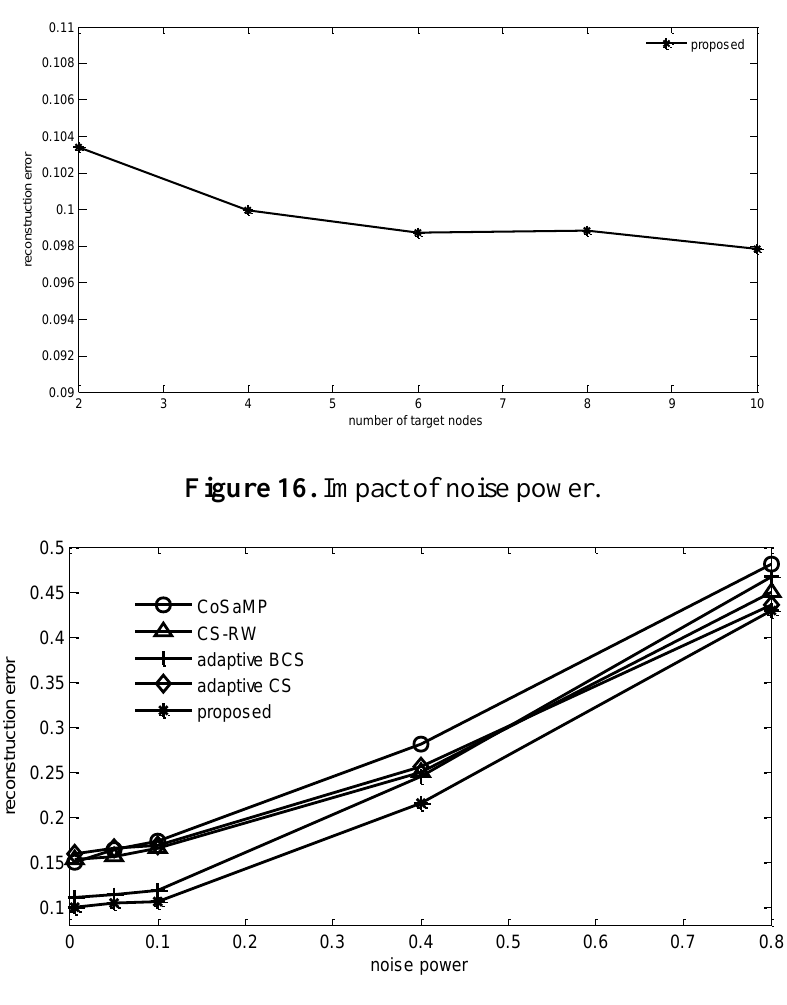
Figure 15. Reconstruction error vs. number of target nodes.